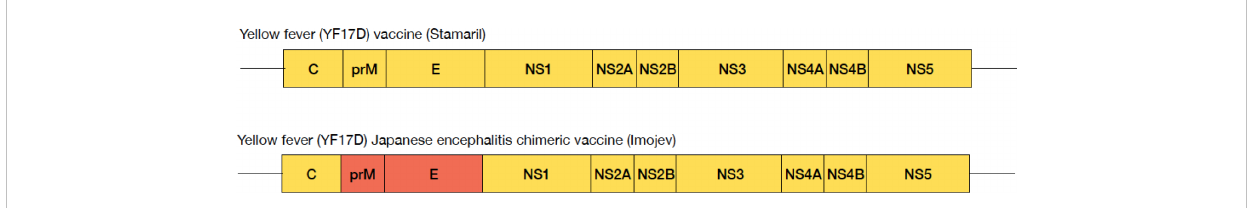
FIGURE 1 Schematic representation of the genome of YF17D and chimeric JE-YF17D vaccines. JE virus prM and E genes (shown in red) have replaced those of YF17D in the chimeric